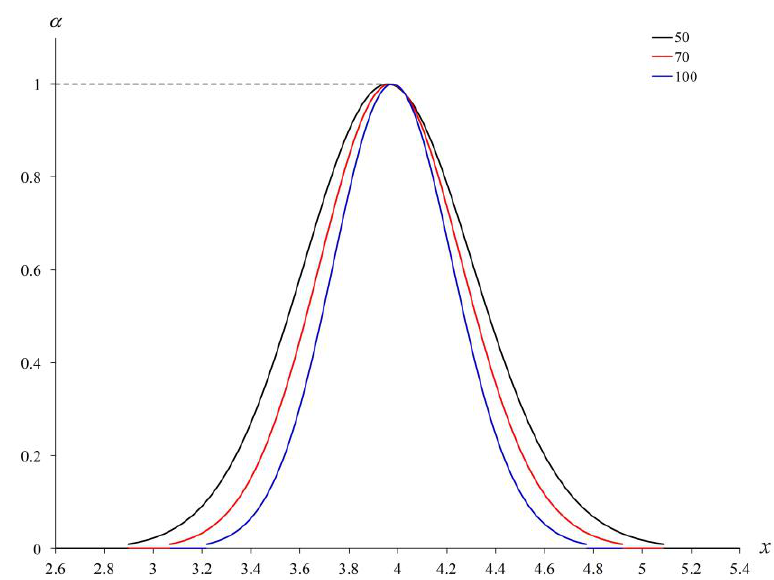
Figure 1. The membership function (MF) of triangular-shaped fuzzy number (TFN) (cid:101) ˆ Q pkh with ˆ Q pkh = 4, √ √ (cid:17) (cid:16) (cid:17)(cid:105) (cid:104) (cid:16) − Z ˆ δ K l K l ˆ γ h / ˆ γ h / , ˆ δ h + Z u for n = 50, 70, and 100. 0 (cid:60) u ˆ h